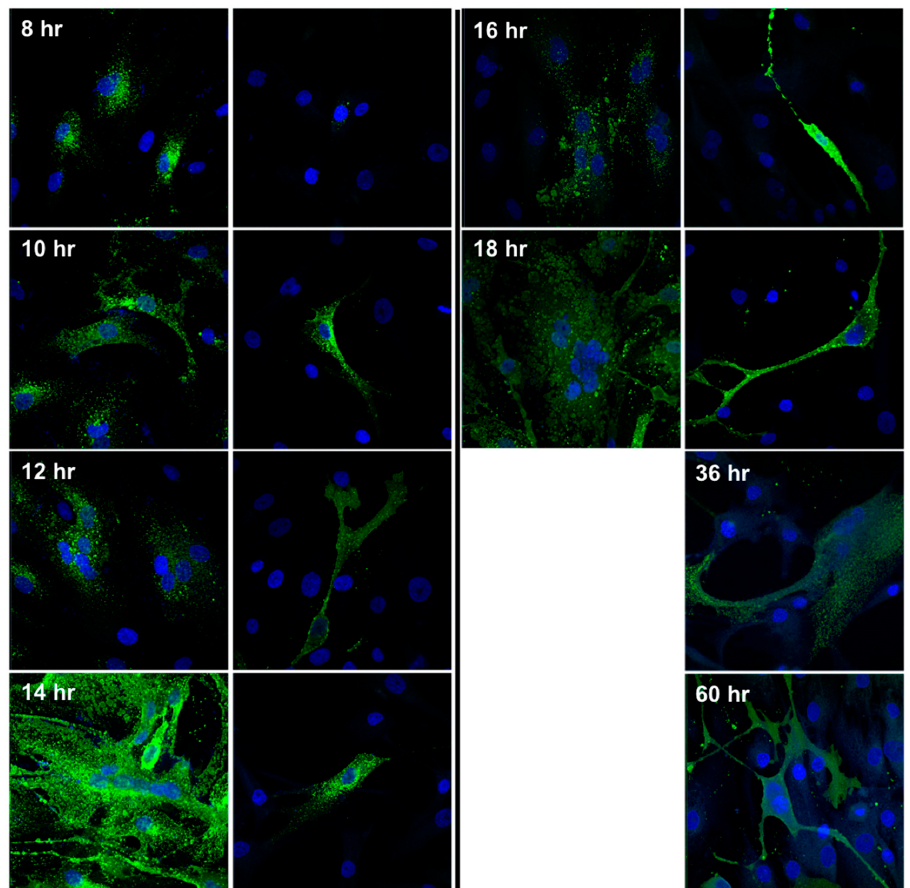
Figure 3. Visualization of cytopathic changes and NiV antigen in ECs and SMCs. Monolayers of the respective cell types were exposed to NiV at a MOI of 5. At the indicated time points, samples were fixed, permeabilized, and stained for NiV NP expression (green), and DAPI for nuclei staining (blue). Images were captured at 20× magnification.